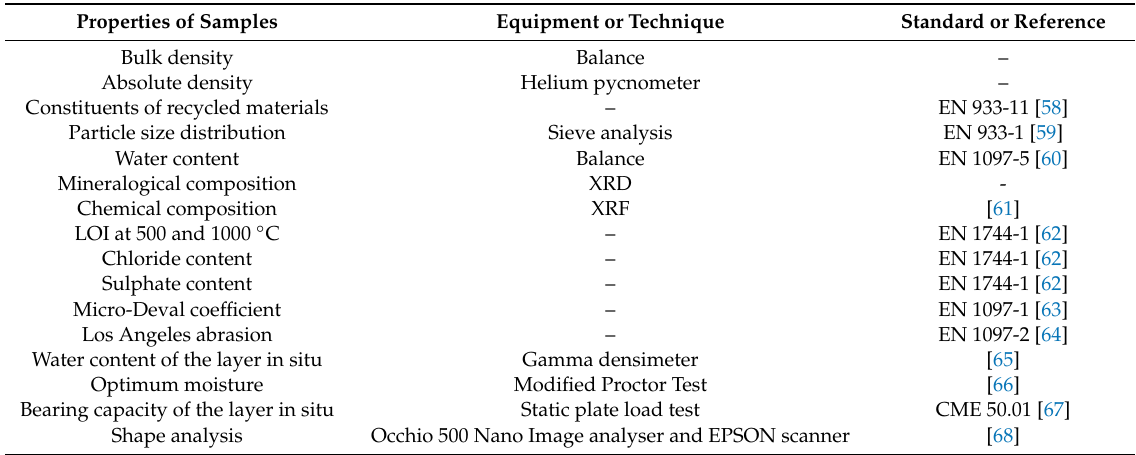
Table 1. Summary of the experimental program conducted in this